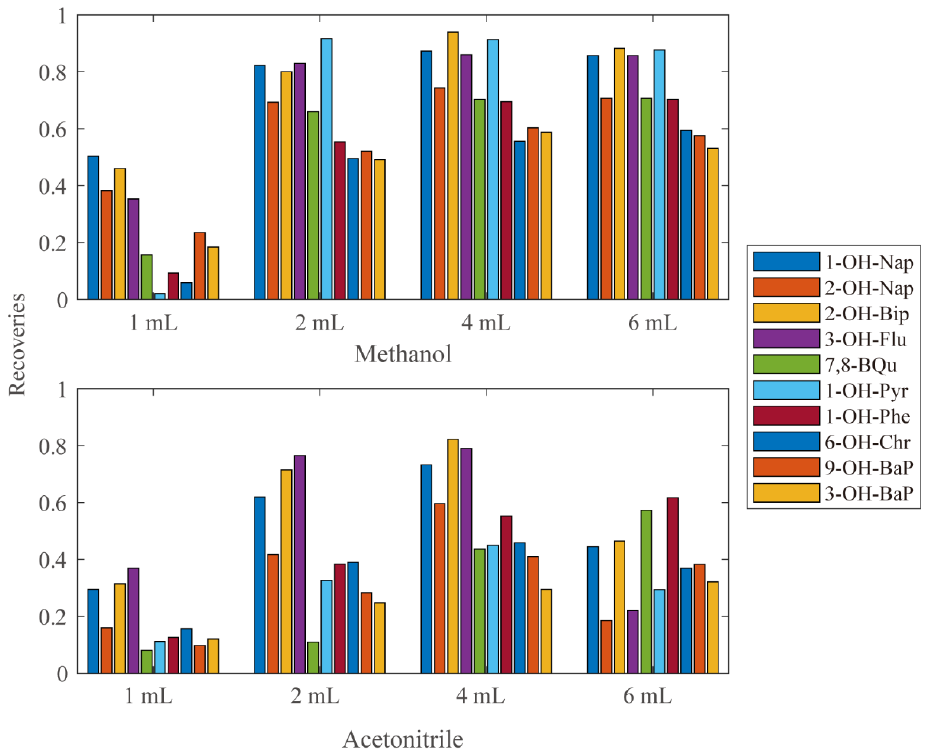
Figure 1. The recoveries using different kinds and amount of elute solvents.